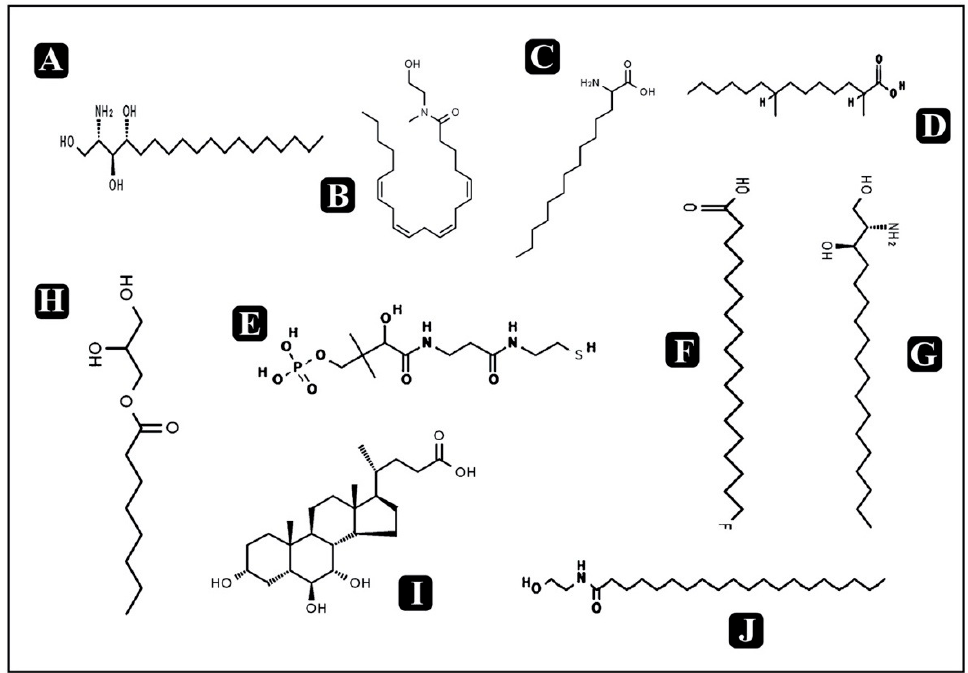
Figure 11. Chemical structures of identified compounds by HR-LCMS. ( A ) Phytosphingosine, ( B ) N-methyl N -(2-hydroxy-ethyl) arachidonoyl amine, ( C ) 2-amino-tetradecanoic acid, ( D ) 2,4-dimethyl-tetradecanoic acid ( E ) D -pantetheine 4'-phosphate, ( F ) 18-fluoro-octadecanoic acid, ( G ) dihydrosphingosine, ( H ) 1-octanoyl-rac-glycerol, ( I ) 3-alpha,6-beta,7-alpha-trihydroxy-5beta-cholan-24-oicacid, ( J ) N -(2-hydroxyethyl) icosanamide. Table 3. Identified major bioactive metabolites by HR-LCMS from P. sophore mucus extract with their bioactivity.